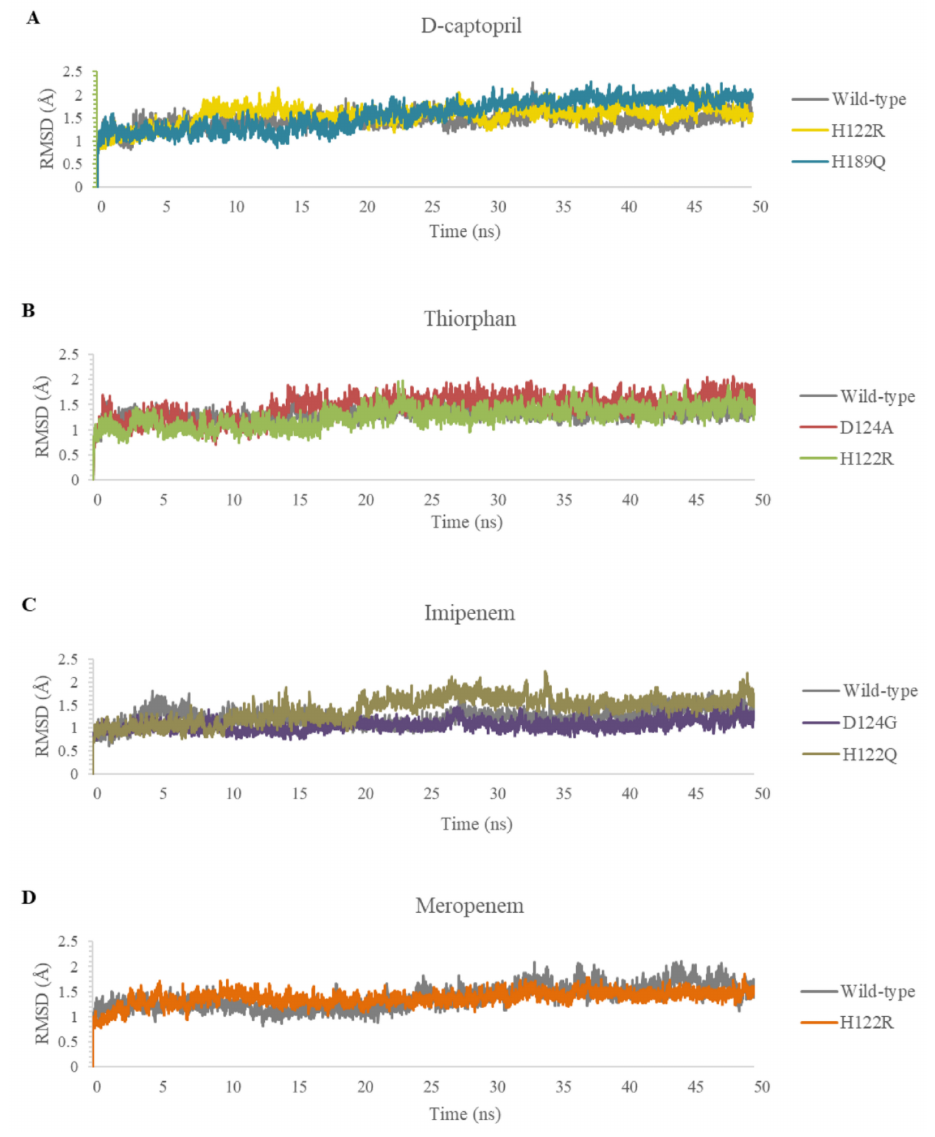
Figure 7. Carbon backbone RMSD profiles of the mutants and the wild type in complex with 4 ligands during MD simulations. ( A ) D-captopril. ( B ) Thiorphan. ( C ) Imipenem. ( D )